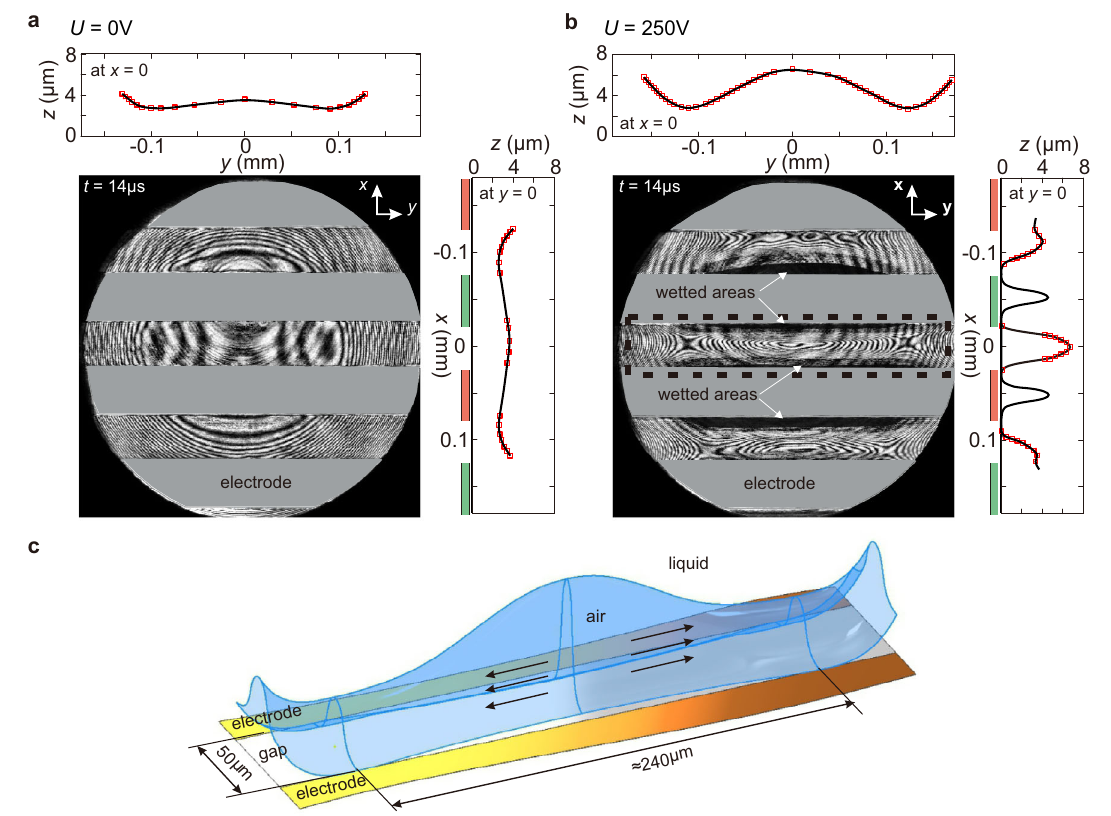
Fig. 2 Spatially periodic dielectrophoretic effect on air fi lms under impacting droplets. a Without dielectrophoretic effect ( U = 0): interferometric pattern and extracted pro fi les of an air fi lm formed between an impacting ethanol droplet and an interdigital electrode substrate. There is no wetting at this moment and the air fi lm pro fi le appears axisymmetrical. b With dielectrophoretic effect ( U = 250 V): interferometric pattern and extracted air pro fi les show that wetting already occurs along the electrode ’ s edges (indicated by arrows). The air layer splits into tunnels on top of the electrodes and the gaps. In both a , b , t = 14 μ s, R = 1.3 mm, v = 1.4 m s − 1 ; optical access to the air fi lm is partially blocked by the electrodes (the grey areas). c Three-dimensional pro fi le of the central air tunnel reconstructed from the interferogram. The air tunnel occupies the area indicated by the dashed box in b